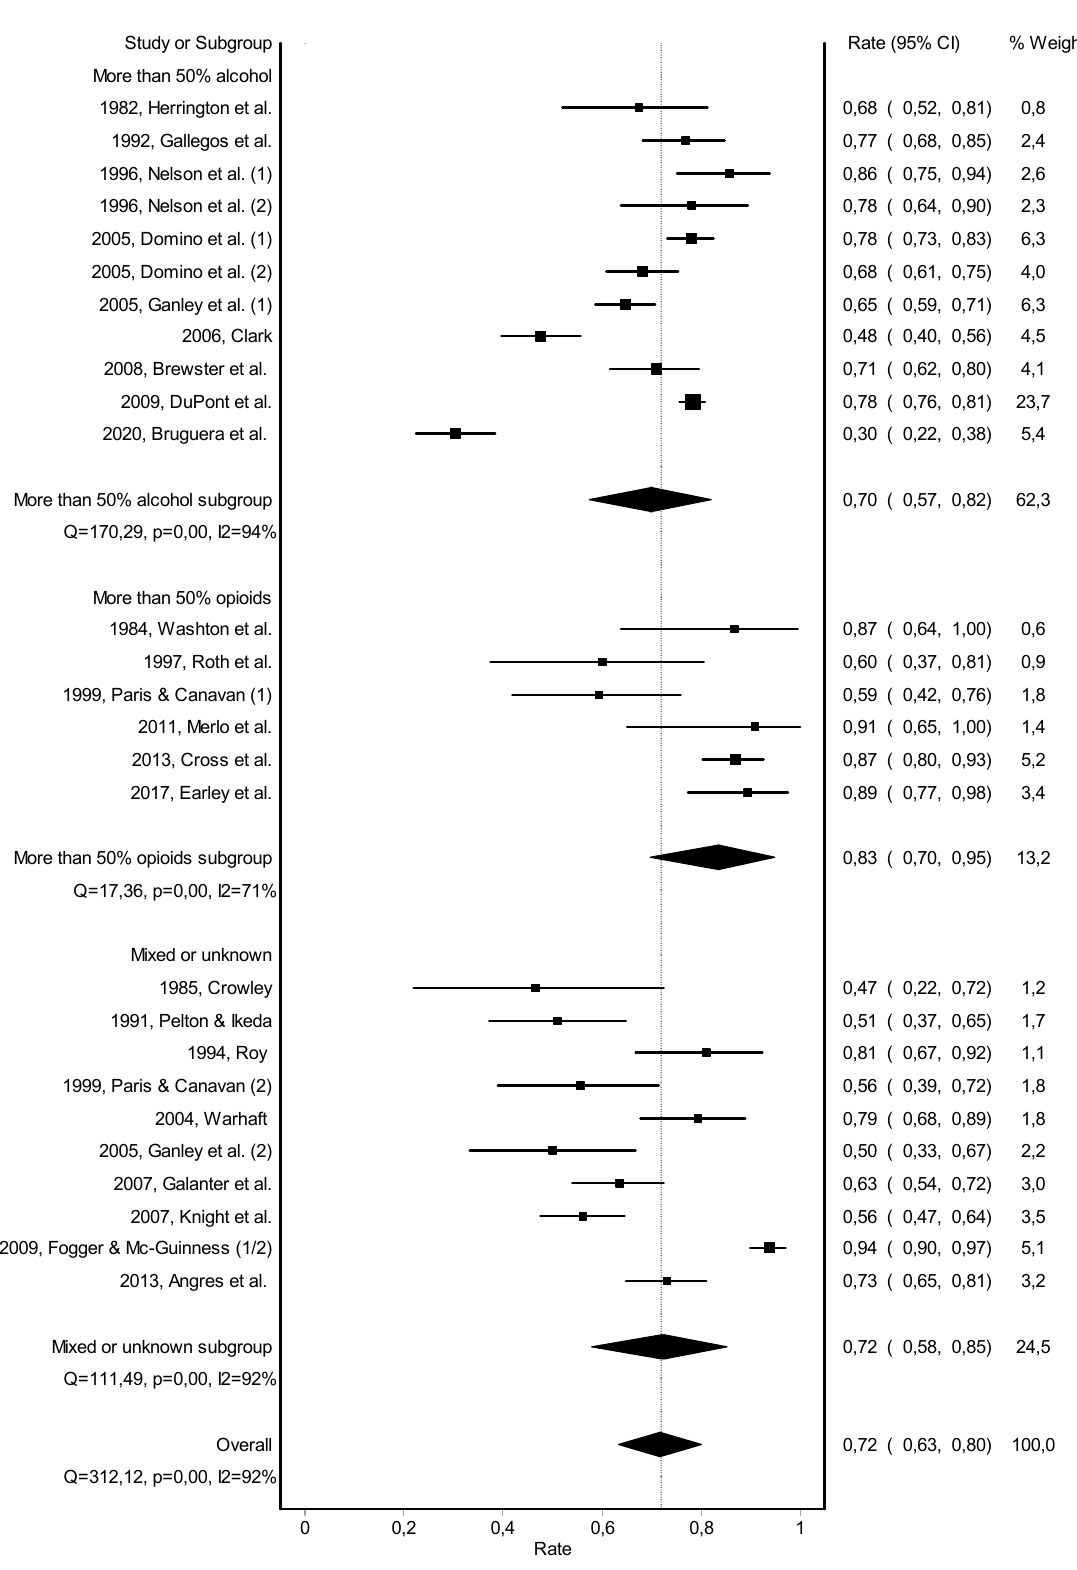
Figure A5. Forest plot of the pooled abstinence rate—subgroup analysis based on type of substance use.